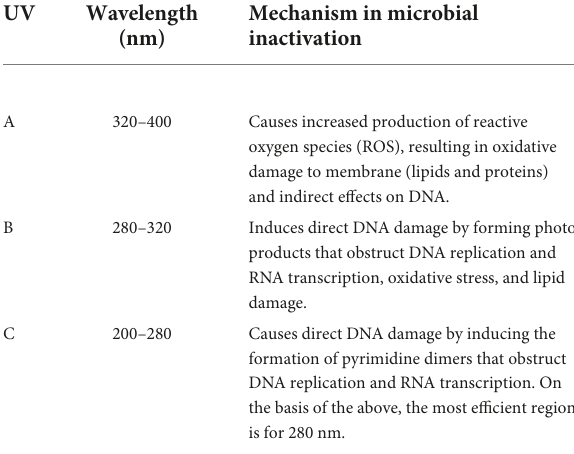
TABLE 2 Mechanism of microbial inactivation for ultraviolet (UV-A, UV-B, and UV-C) ranges